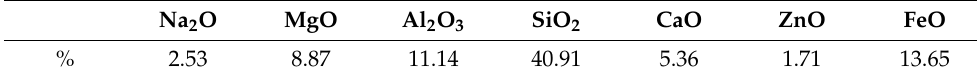
Table 1. Diabase Mud Oxide Composition obtained from ED-XRF analysis